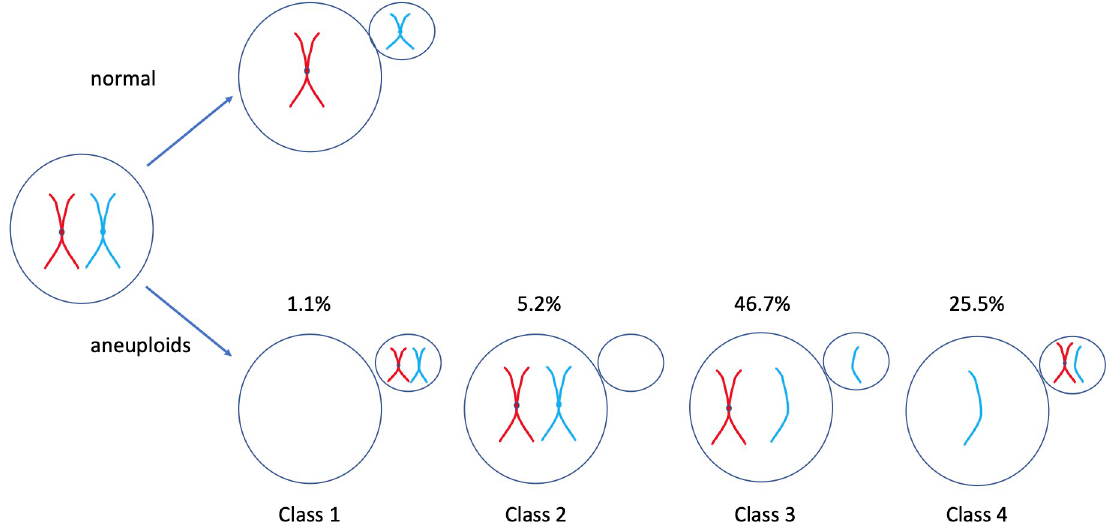
Fig 2. Relative rates of meiosis I error in 20,000 human oocytes (data from [53]). The percentages shown are the percentages of all errors that are each type of error. Missing is class 5, complex errors (21.5%).